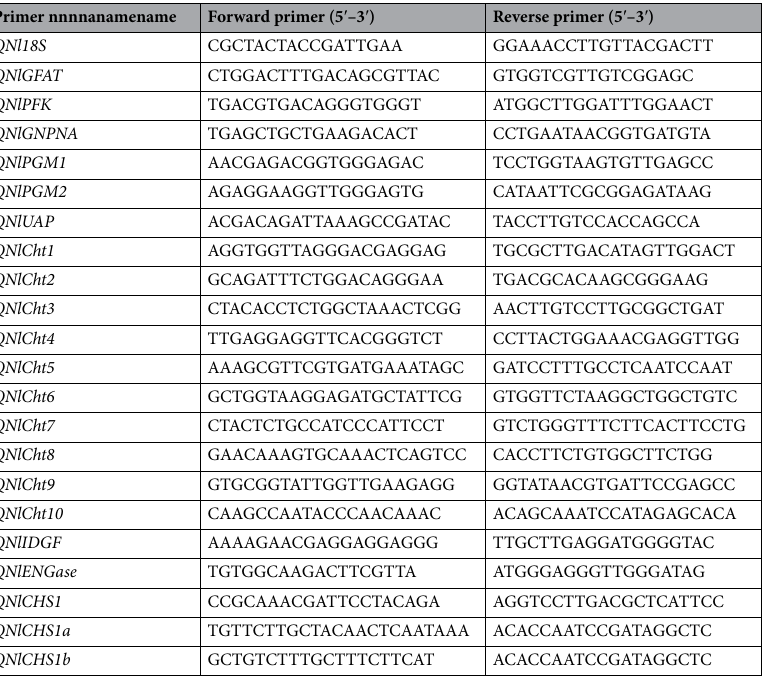
Table 1. Gene-specific primers used for quantitative real-time polymerase chain reaction